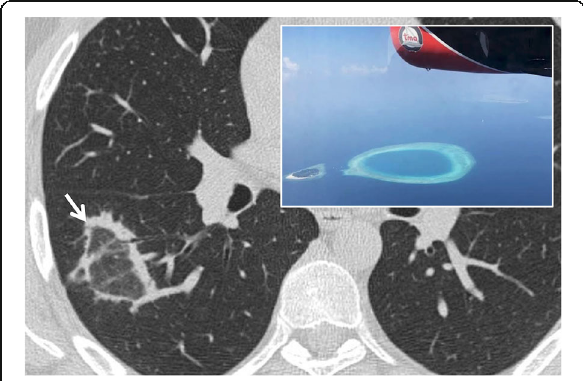
Fig. 4 Atoll sign. The so called “ atoll sign ” (white arrow) is represented by a central ground glass area bordered by a peripheral consolidation. This CT finding — similar to the oceanic atoll — is frequently observed in patients with COP; it has been also called “ reversed halo sign